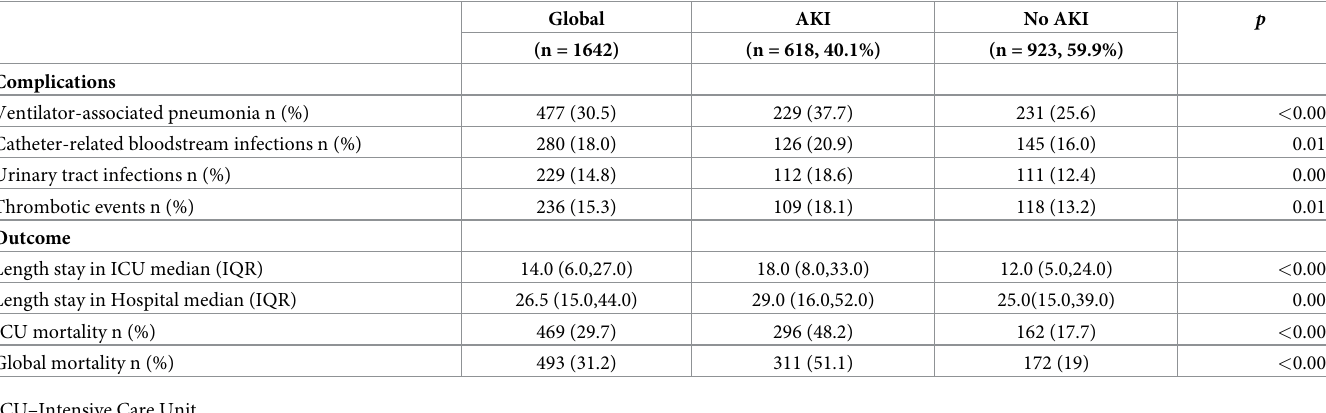
Table 5. Complications and